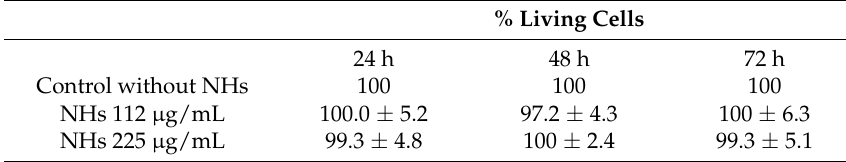
Table 1. Toxicity results expressed as percent of Jurkat T lymphocytes living